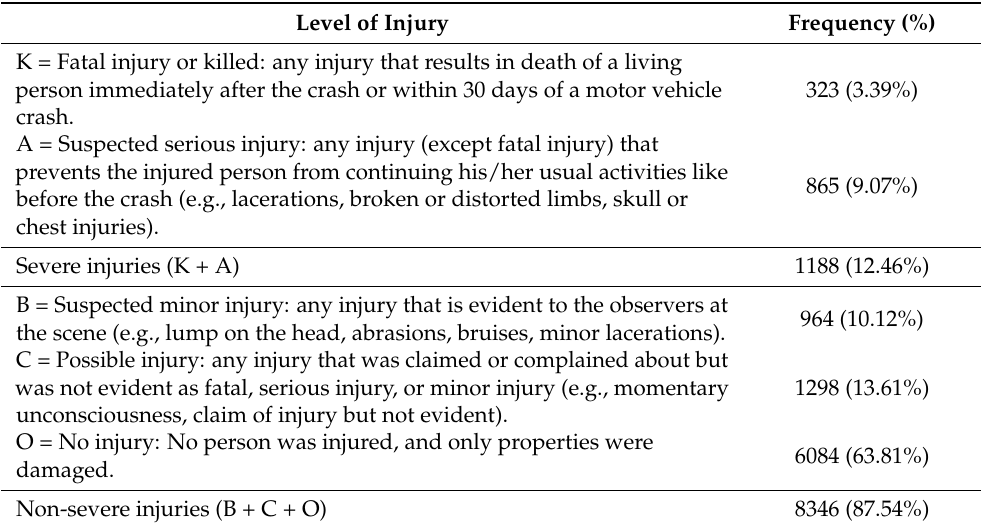
Table 2. Definitions and distributions of injury severity (dependent